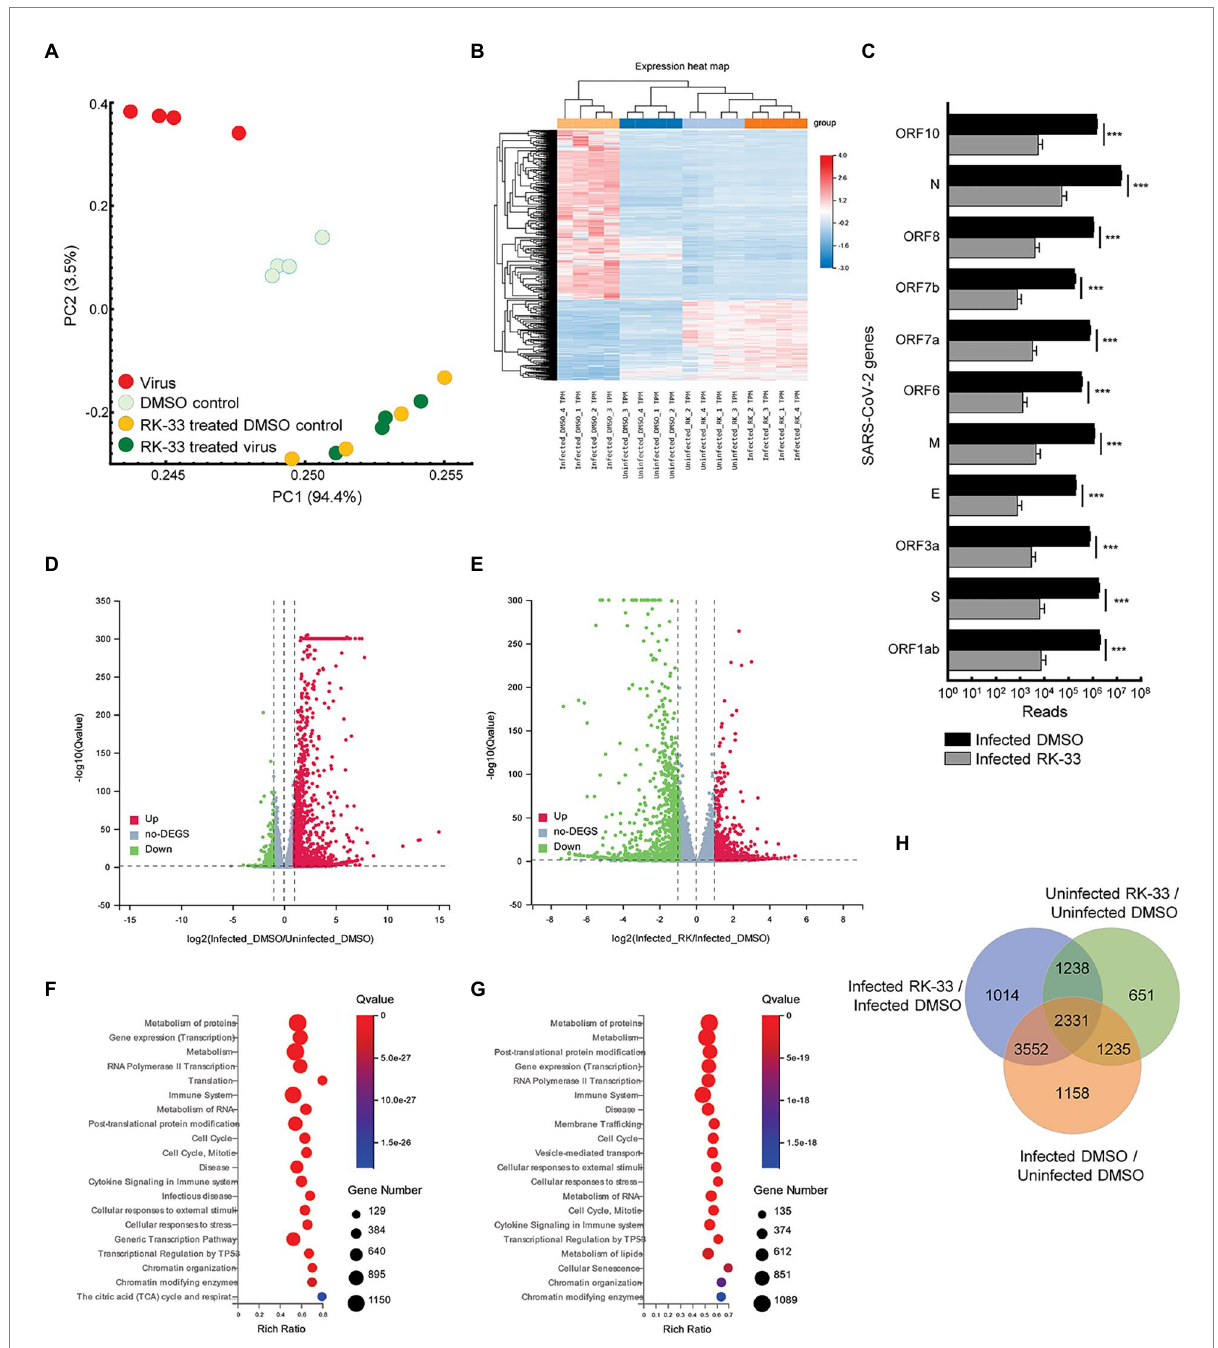
FIGURE 1 Transcriptomics of viral infected Calu-3 cells. (A) PCA plot of RNA-seq data. PC1 accounts for 94% of the variation between the sample clusters. (B) Dendrogram and Heat map of RNA-seq data showing relationship between the various samples. Dendrogram was constructed using z-scores of TPM values of all RNA-seq sample reads. Horizontal sorting was by cluster order. (C) Histogram of SARS-CoV-2 RNA that are downregulated by RK-33 treatment of virally infected Calu-3 cells. * p < 0.05, ** p < 0.005, *** p < 0.0005. (D) Volcano plot displaying effect of virus infection on Calu-3 cells. Genes differentially regulated in virally infected untreated samples were compared to uninfected samples. The X -axis represents the log2 fold change of the difference, and the Y -axis represents the-log10 significance value. Red represents DEG upregulated >2-fold change, green represents DEG downregulated, and gray represents non-DEGs. (E) Volcano plot displaying effect of RK-33 on virus infected Calu-3 cells. (F) Bubble plot displaying significantly enriched (Q < 0.05) Reactome pathways affected by SARS-CoV-2 infection of Calu-3 cells. X -axis displays the enrichment ratio which indicates more enrichment toward the right. Larger bubbles indicate more genes. (G) Reactome enrichment pathways affected by RK-33 treatment of virally infected Calu-3 cells displayed as a bubble plot. (H) Venn diagram displaying the number of genes dysregulated by SARS-CoV-2 infection, RK-33 treatment of uninfected cells, and RK-33 treatment of infected